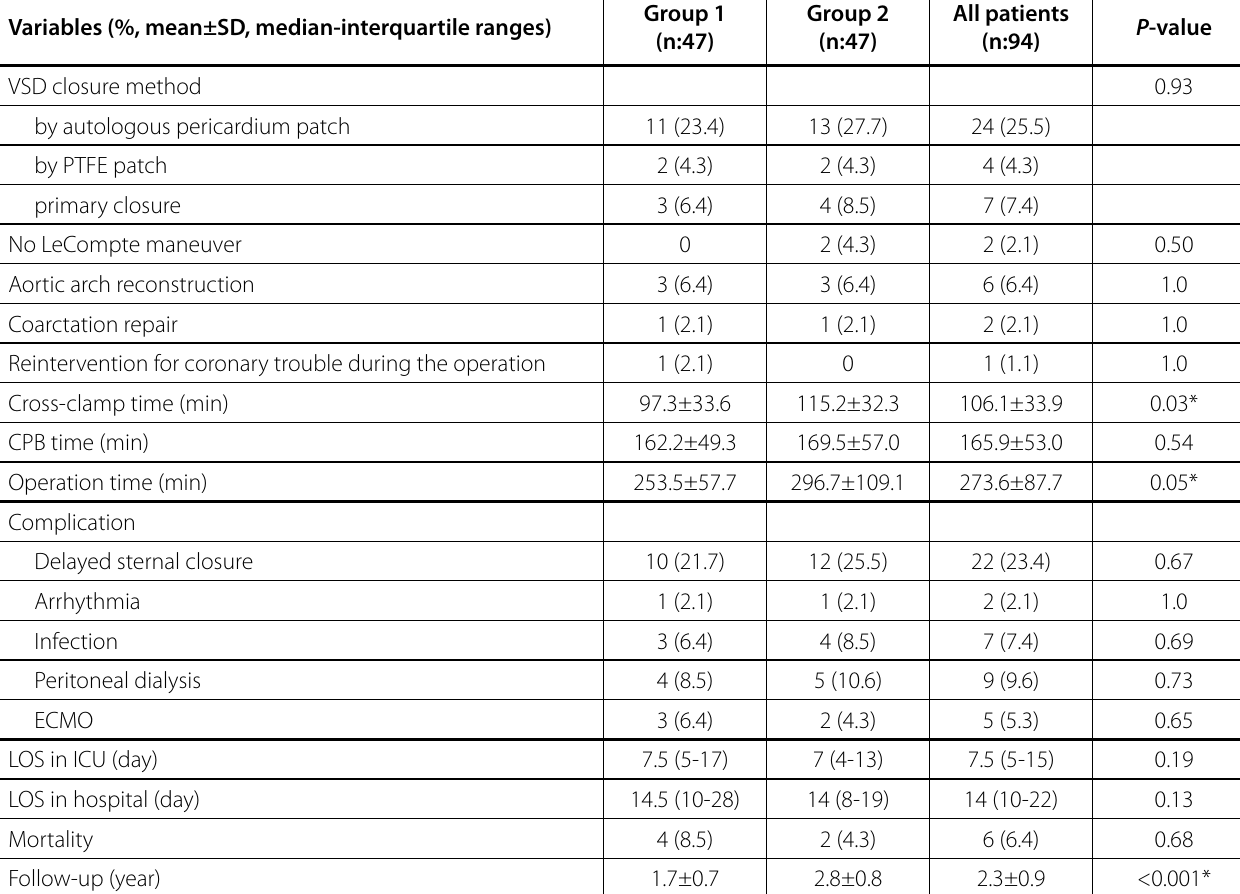
Table 3 . Operative data and postoperative outcomes. Variables (%, mean±SD, median-interquartile